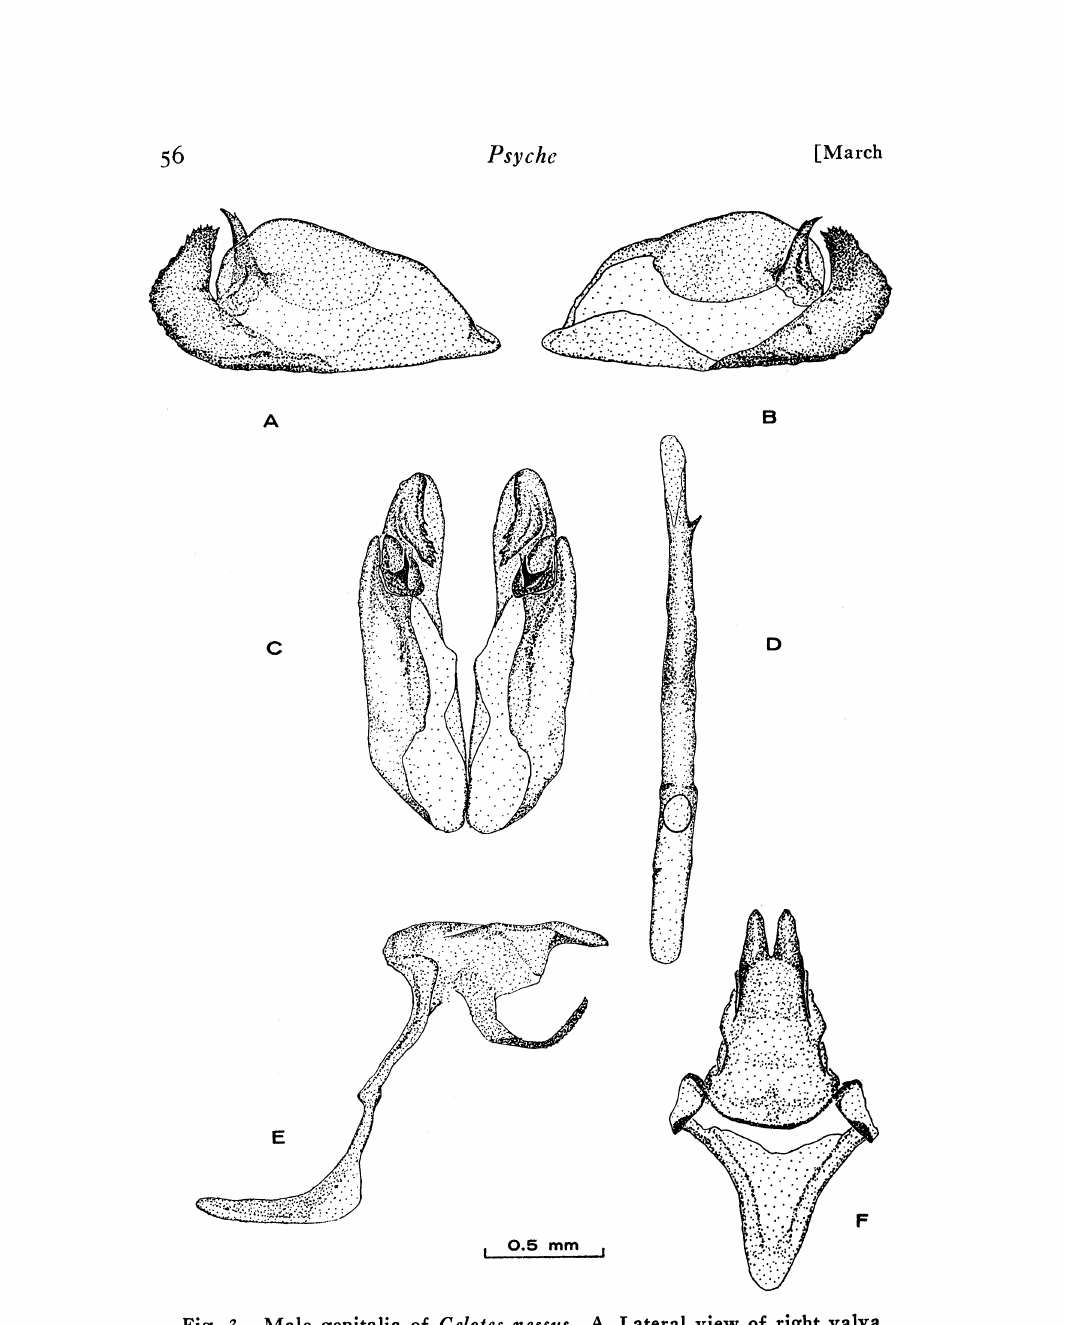
Fig. 3. Male genitalia of Celotes nessus. A. Lateral view of right valva. B. Medial view of right valva. C. Dorsal view of both valvae. D. Dorsal view of aedeagus. E. Left lateral view of uncus, tegumen, gnathos, vin- culum, and saccus. F. Dorsal view of uncus, tegumen, vinculum, and saccus. [A and B, drawn from male from Palo Duro Canyon, 2800 feet, Randall County, Texas, V-10-1959 (J. M. and S. N. Burns) C to F, from male from Austin, Travis County, Texas, V-26-1966 (J. M.